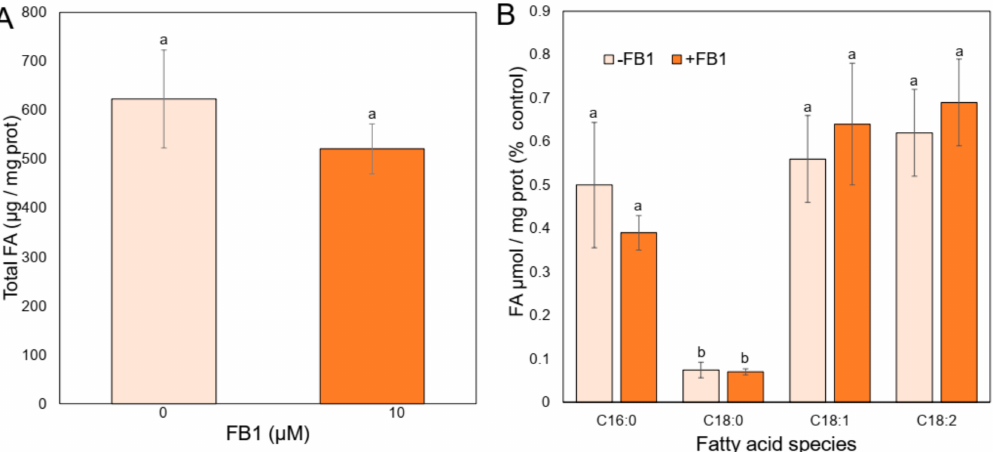
Figure 4. Fatty acids from PM of maize embryos exposed to FB1. Maize embryos were imbibed with 10 µ M FB1 for 24 h, their PM fractions isolated, membrane lipids extracted and derivatized to obtain the correspondent methyl esters to be analyzed by gas chromatography. ( A ) Total fatty acids from PM from control and FB1-imbibed maize embryos. ( B ) Main fatty acids from control and FB1-imbibed maize embryos. Data are the means ± SD of 3–5 independent experiments. Holm–Sidak t -test was performed using GraphPad Prism version 8.0 for Windows, GraphPad Software (San Diego, CA, USA). 2.5. LCBs but Not Ceramide Inhibit H + -ATPase Activity When Directly Added to the